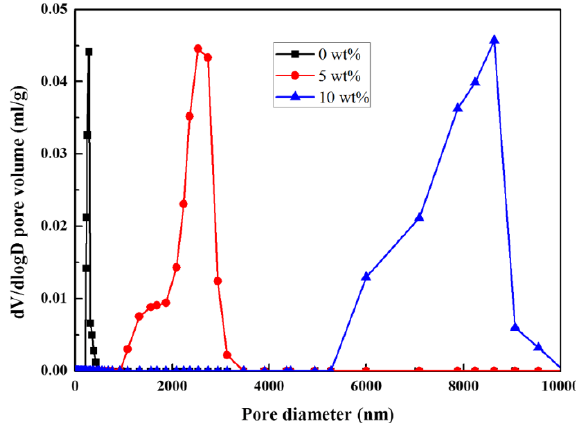
Figure 3. Pore size distribution of porous zirconia ceramics with different stearic acid content.